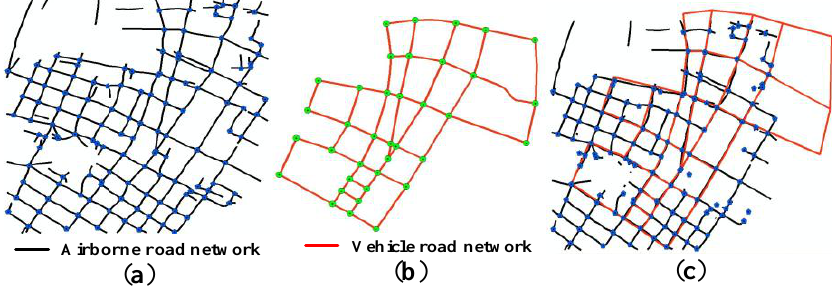
Figure 8. Coarse registration with road networks. ( a ) Airborne road network (black lines); ( b ) Vehicle road network (red lines); ( c ) Registered road